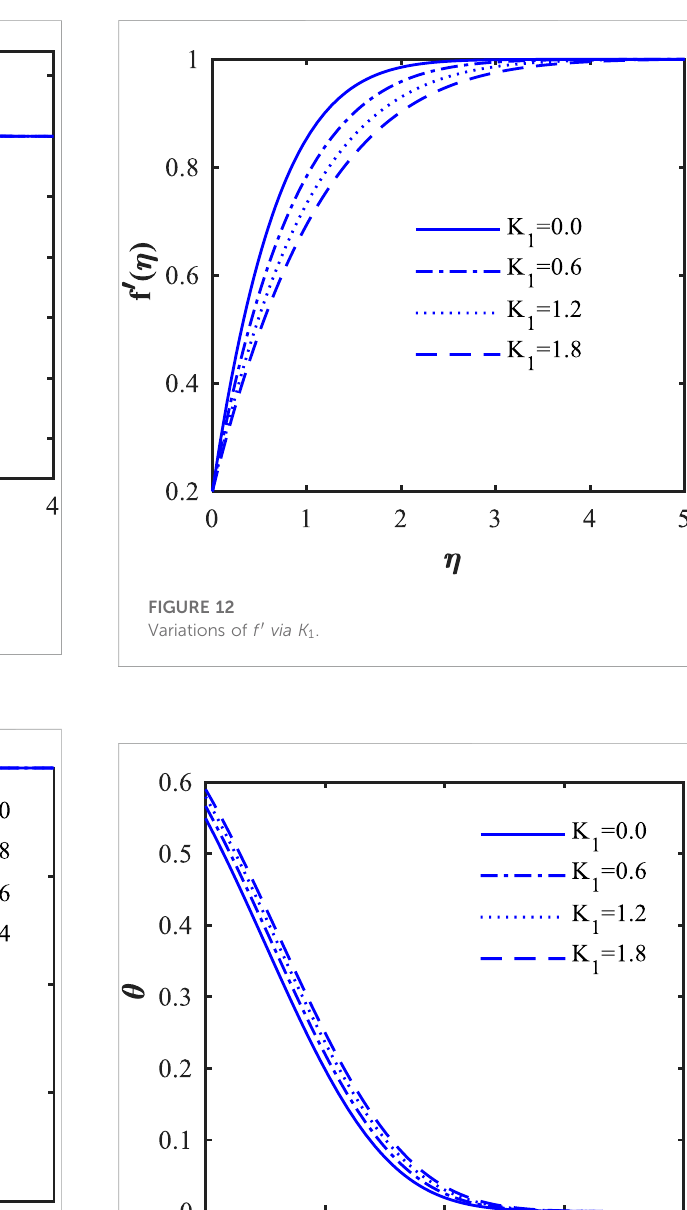
FIGURE 11 Variations of f ′ via K 2 .